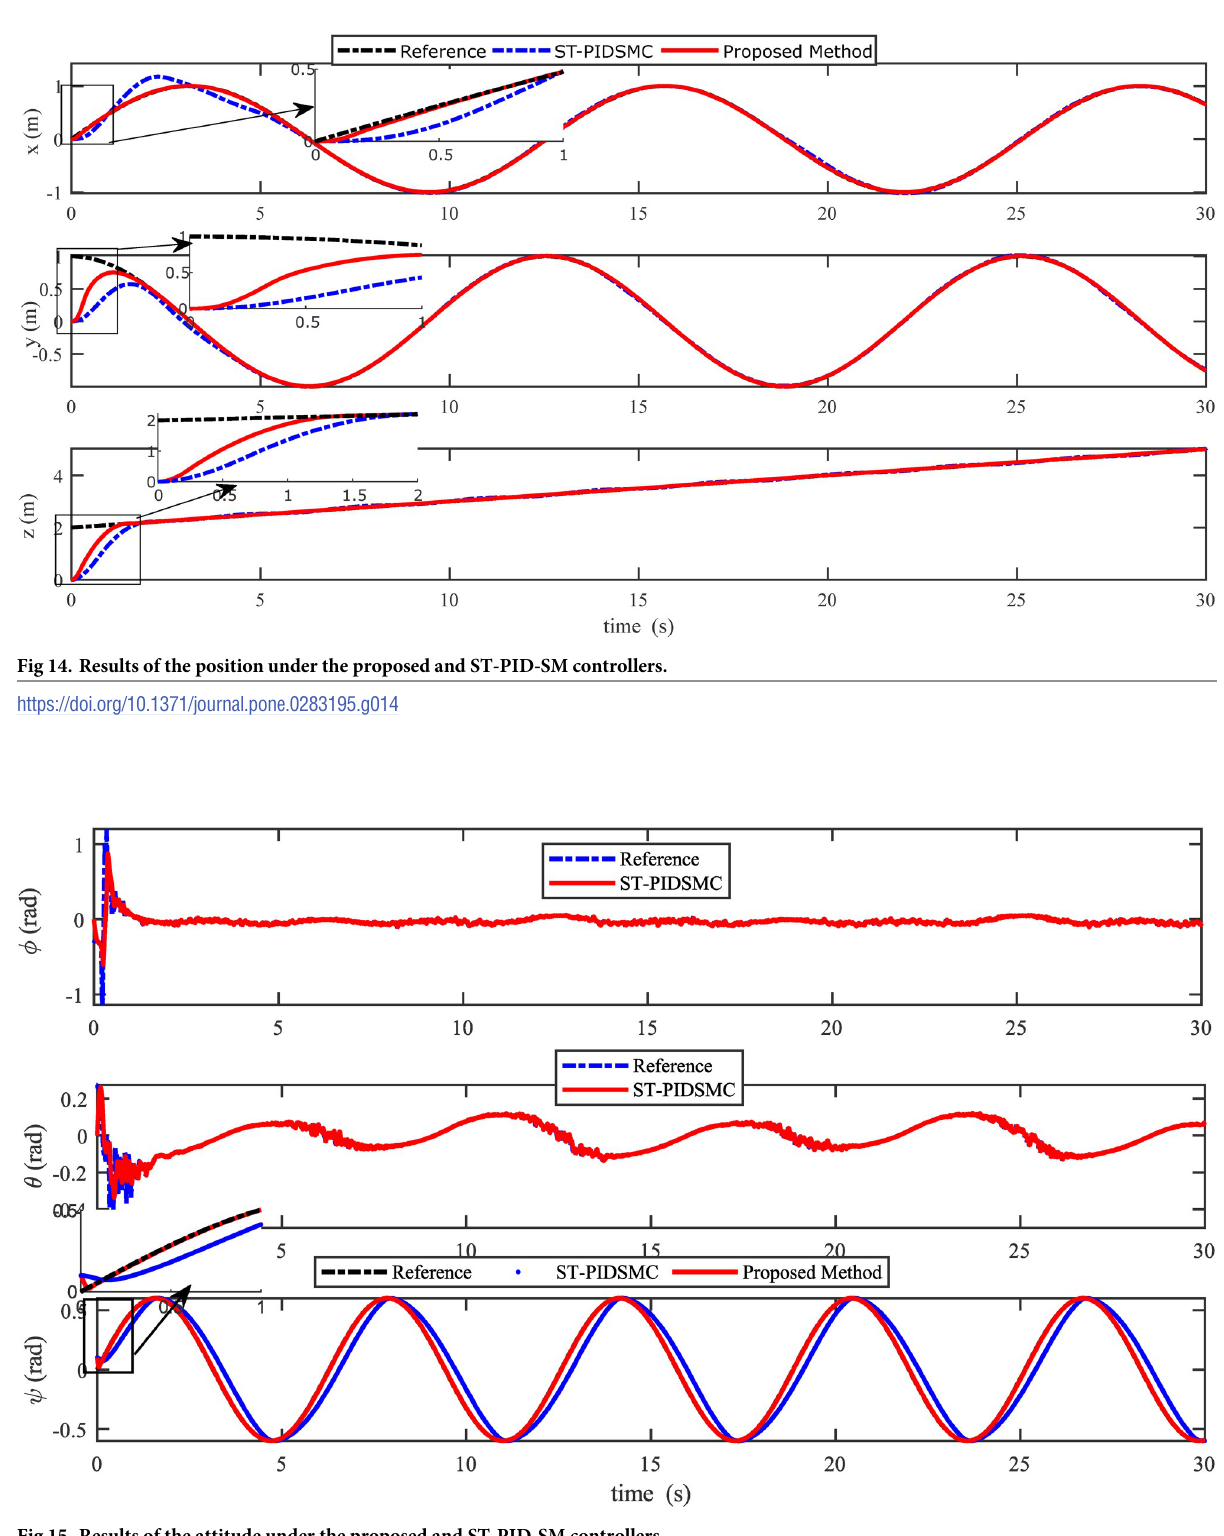
PLOS ONE | https://doi.org/10.1371/journal.pone.0283195 April 24, 2023 21 /